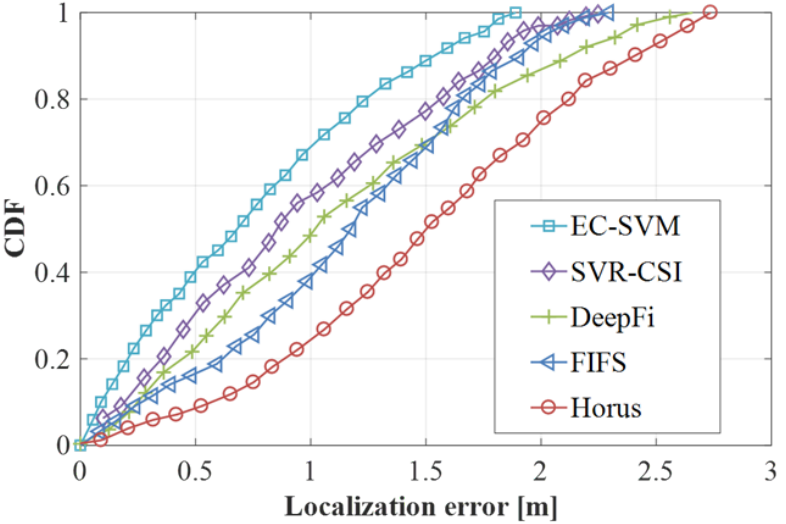
Figure 12. Comparison of positioning accuracy of four